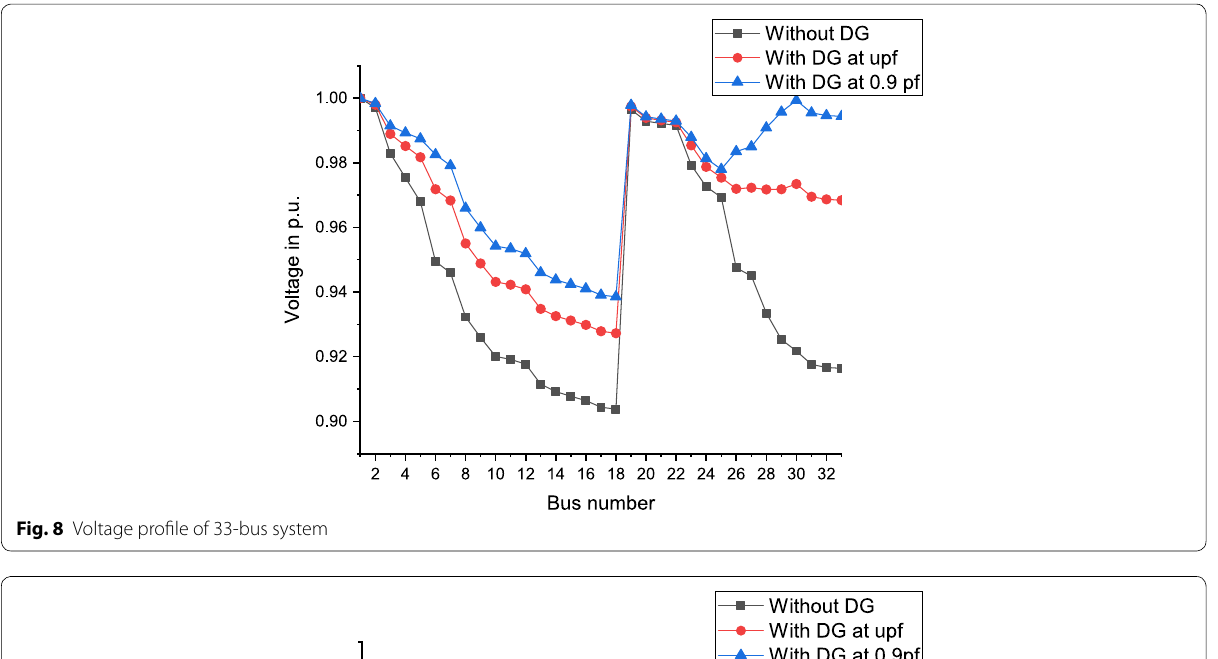
Fig. 8 Voltage profile of 33-bus system